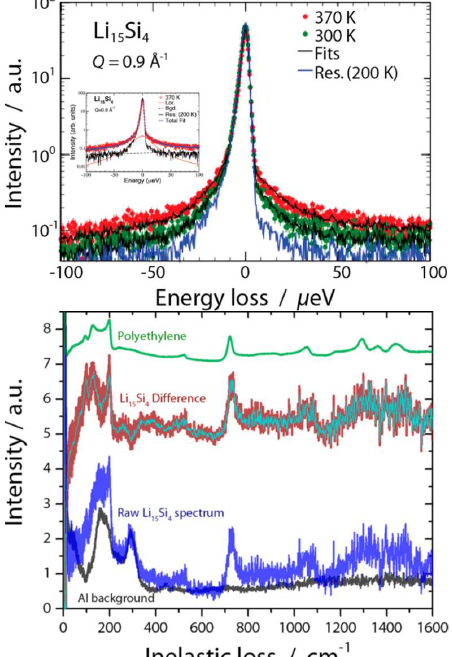
Fig. 13 . QENS (top) and INS (bottom) spectra measured from an amorphous Li x Si anode material. Reprinted with permission from [80]. Copyright 2017 American Chemical Society.